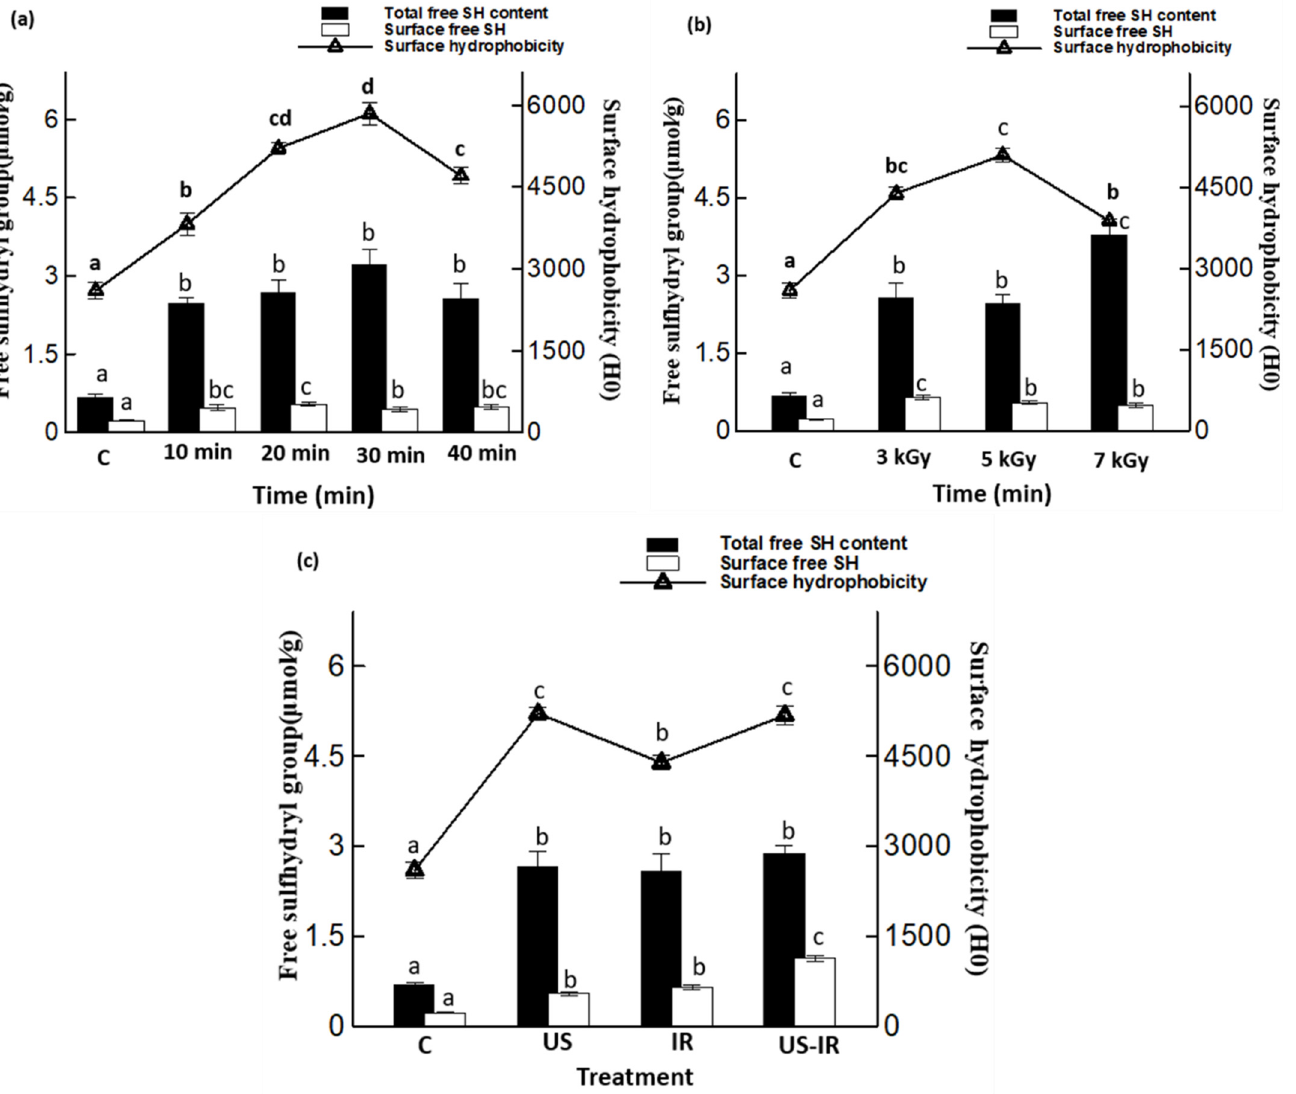
Figure 2. Sulfhydryl group content in cricket proteins for untreated samples (C), samples treated by ultrasound (US) at different times (10, 20, 30 and 40 min) ( a ), by γ -irradiation at different doses (3, 5 and 7 kGy) ( b ), and by combined ultrasound-assisted γ -irradiation (US-IR; 20 min; 3 kGy) ( c ). Different letters above the bars indicate significant differences among the mean values of the samples ( p ≤ 0.05). Data shown is the mean ± SD ( n = 3).